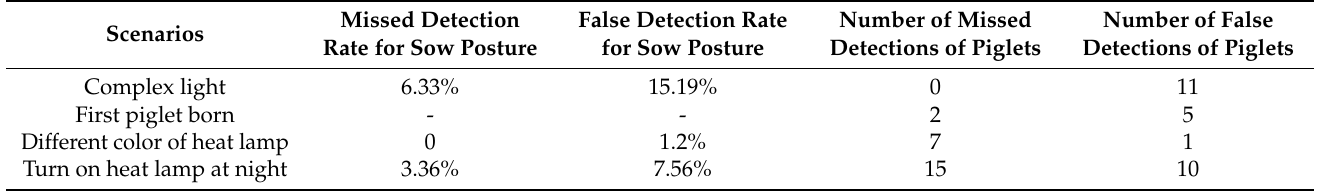
Table 2. Test situation of YOLOv5s model in complex